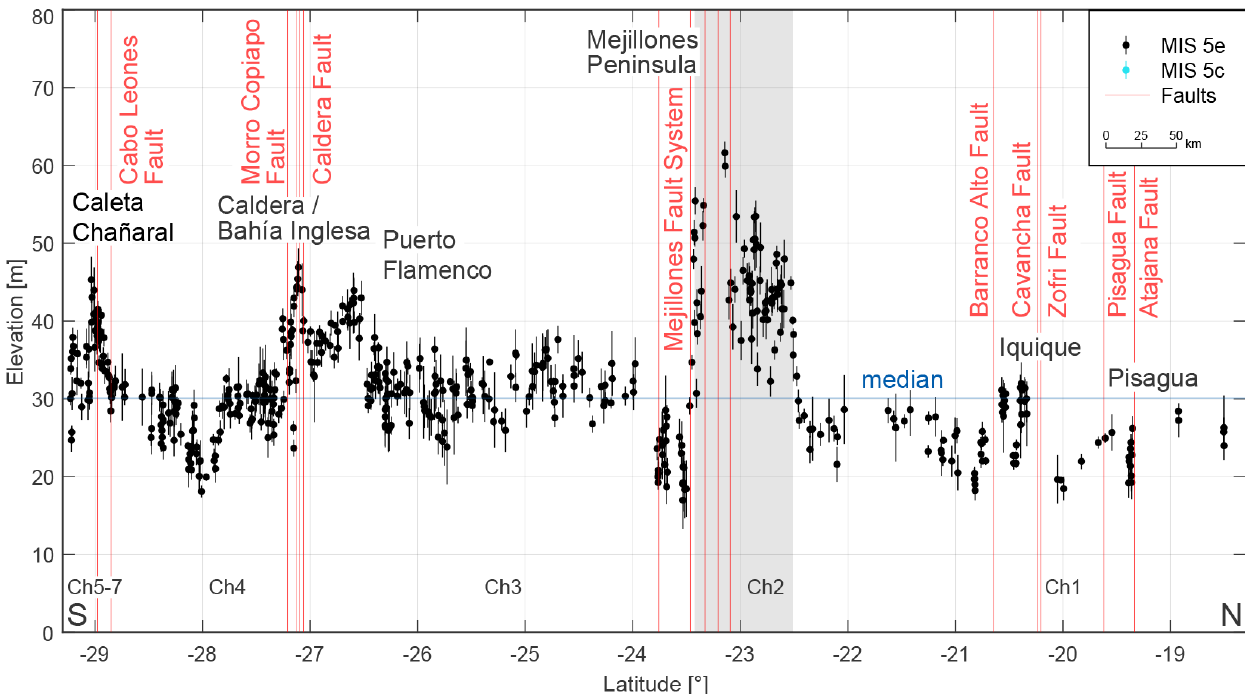
Figure 8. Measured shoreline-angle elevations of MIS 5e and 5c terraces in northern Chile (Ch). Faults and asymmetrically uplifted marine terraces of up to 60m elevation characterize the Mejillones Peninsula, reaching values below 20m at the southern margin. Terrace elevations attain peak values south of Puerto Flamenco, at Caldera and Bahía Inglesa, and north of Caleta Chañaral, while in between minimum elevations below 20m prevail (north of Carrizal Bajo). Median elevation: 30.1m. For location see Fig.